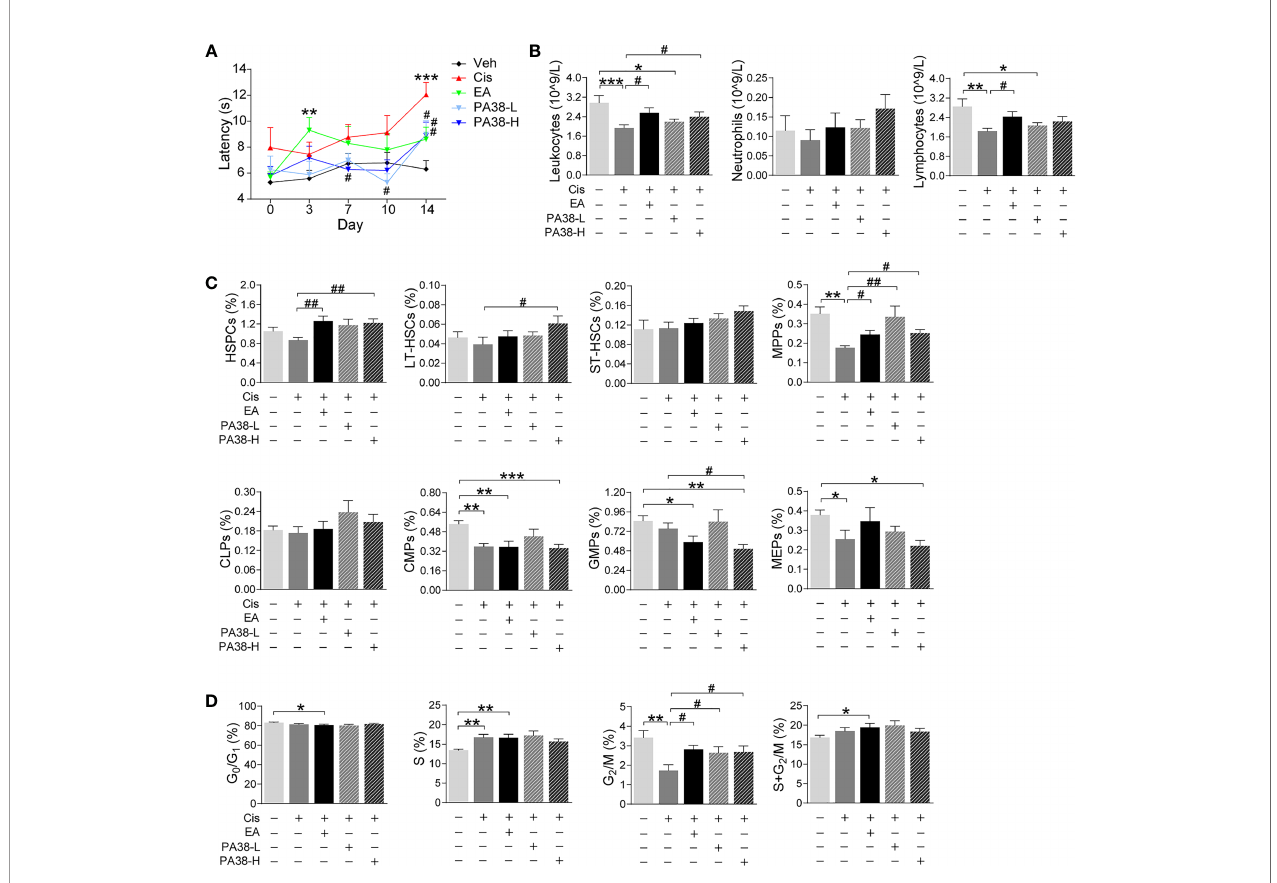
FIGURE 5 | PAC1-agonist mimics electroacupuncture-induced protection to cisplatin. (A) Representation of the latency time (seconds) in hot-plate tests of mice with control (Veh), cisplatin (Cis; 3 mg/kg), EA (cisplatin + electroacupuncture), cisplatin mice were treated with low (10 m g/kg) or high (50 m g/kg) concentrations PAC1-agonist, PACAP1-38 (Veh, n =8; Cis, n =7; EA, n =8; PA38-L, n =8; PA38-H, n =7), P values were calculated using two-way repeated-measures ANOVA. (B) Peripheral blood counts of speci fi c subpopulation of leukocytes ((Veh, Cis, EA: n =6; other groups, n =7). (C) Analyses of hematopoietic BM cell subpopulation (Veh, Cis, EA: n =7; PA38-L, PA38-H: n =8). (D) Quanti fi cation of PI nuclear staining of BM cells (Veh, n =8; Cis, n =7; EA, n =8; PA38-L, n =8; PA38-H, n =7). Data are mean ± SEM, * P < 0.05, ** P < 0.01, *** P < 0.001 vs Veh; # P < 0.05, ## P < 0.01 vs